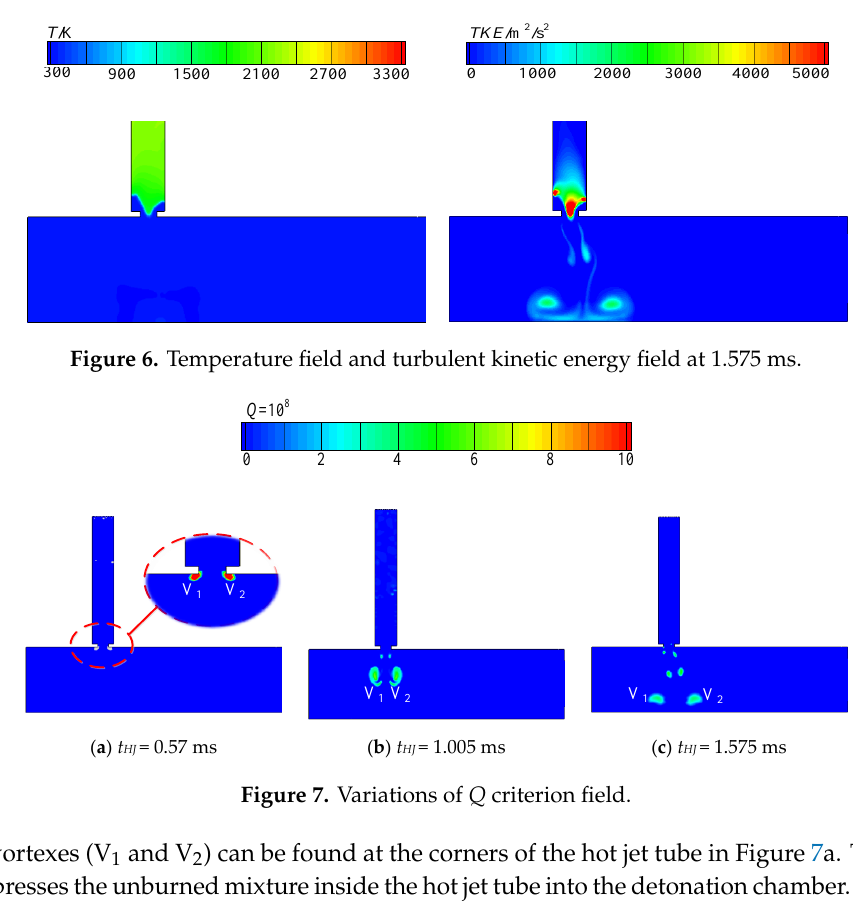
( f ) Figure 5. Hot jet formation process ( a ) t HJ = 0ms, ( b ) t HJ = 0.15ms, ( c ) t HJ = 0.3ms, ( d ) t HJ = 0.6ms, ( e ) t HJ = 0.9ms, ( f ) t HJ = 1.2 ms. From Figure 5a–c, high-temperature ignition source triggers laminar flame, and an expansion wave is generated during thermal mixture expansion [44]. Due to the obstructive effect of the wall boundary, the expansion waves are continuously superimposed and reflect on the flame. The flame wrinkles and the convex flame front propagates downstream at a laminar flow velocity of about 90m/s. In Figure 5d, since the pressure wave generated by the convex flame pushes unburned mixture to move towards near the wall, the high-density unburned mixture is formed near the wall and accelerates the flame propagation in this area. Then flame propagation speed near the wall increases rapidly, the contact area between flame and unburned mixture begins to decrease. Mass and thermal diffusion will also decrease. Flame front develops into an approximate plane, and flame propagation speed slows down. Figure 6 shows the field of temperature and turbulent kinetic energy at 1.575 ms. The jet flame enters the detonation chamber, so t TDC is assumed to be 0ms at this time. To further increase the jet velocity entering chamber, inspired by Ref. [18], the outlet of the hot jet tube has been designed as a sudden shrunken form as shown in Figure6. Due to the narrow structure, convex flame propagates